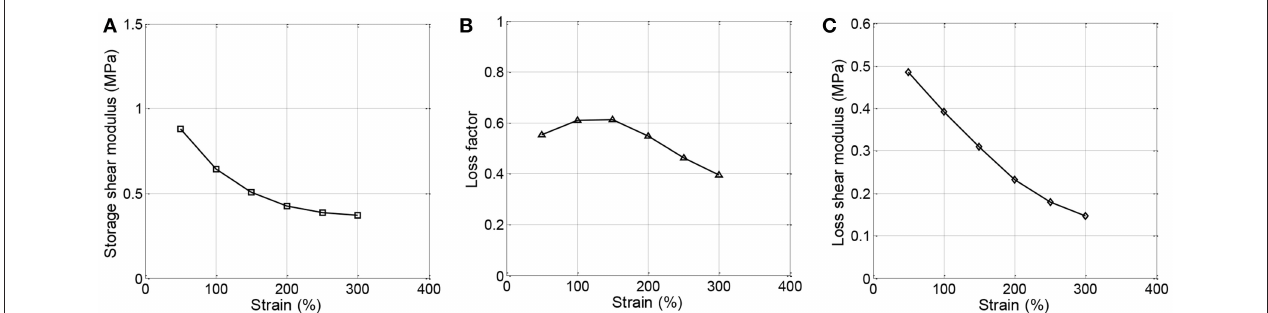
Frontiers in Materials |